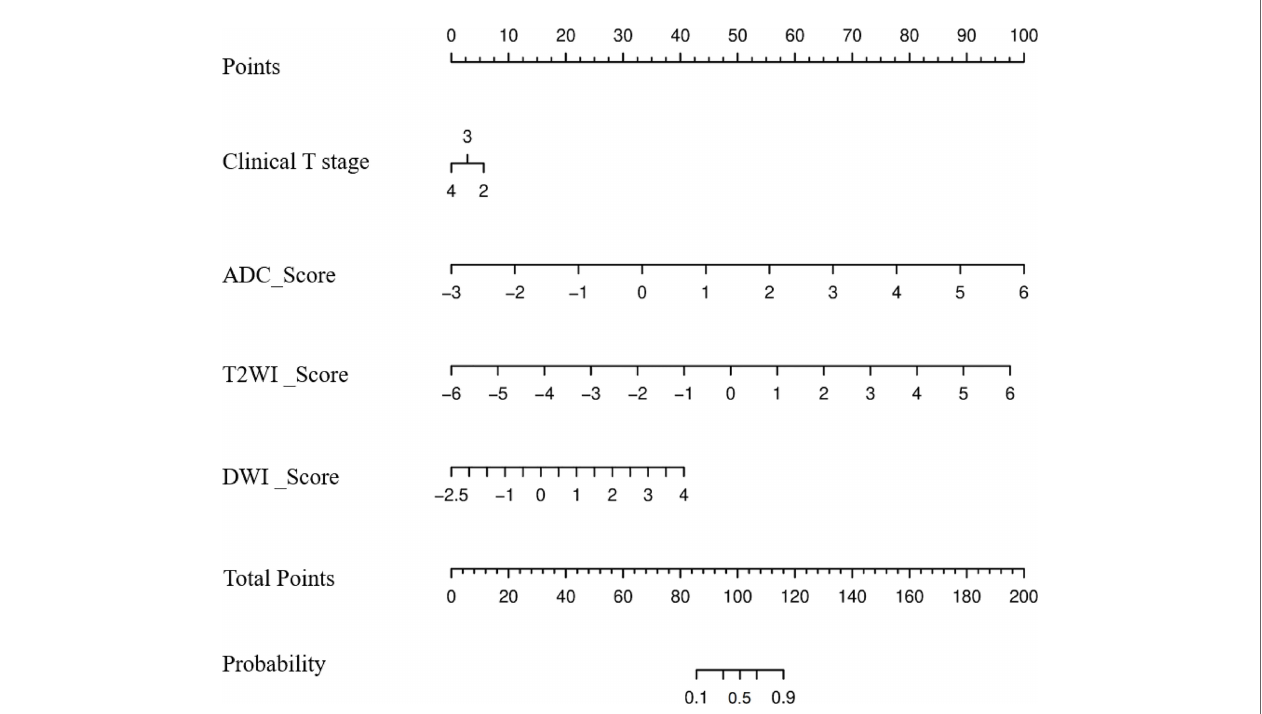
FIGURE 3 | Nomogram to predict the probability of becoming a good responder after neoadjuvant chemotherapy.